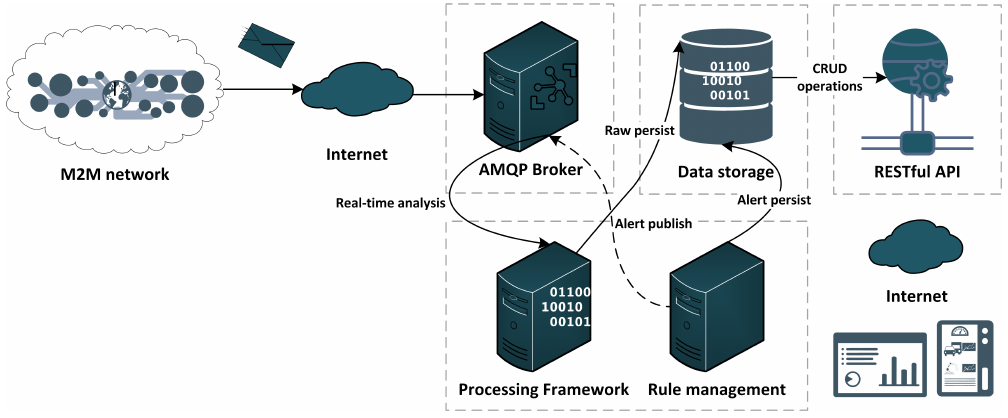
Figure 10. Computational Platform